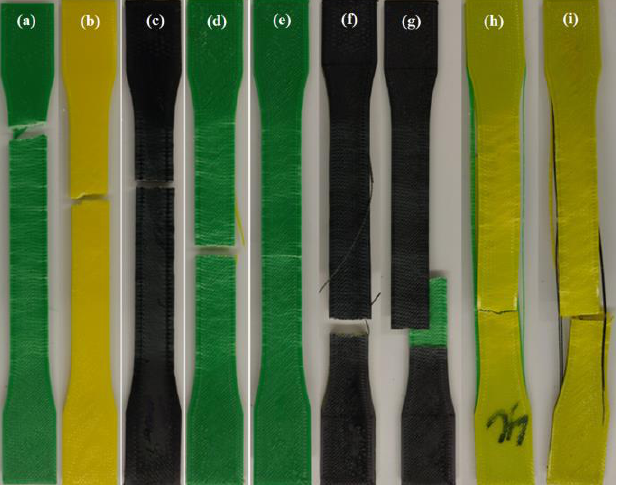
Figure 9. Examples of failure tested specimens: ( a ) ABS; ( b ) PLA; ( c ) HIPS; ( d ) ABS-PLA-ABS; ( e ) ABS-HIPS-ABS; ( f ) HIPS-PLA-HIPS; ( g ) HIPS-ABS-HIPS; ( h ) PLA-ABS-PLA; and ( i ) PLA-HIPS-PLA.